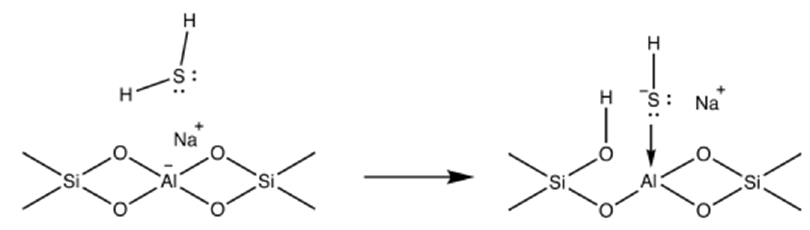
Figure 6. Diagram of dissociative H 2 S adsorption on an aluminosilicate zeolite.